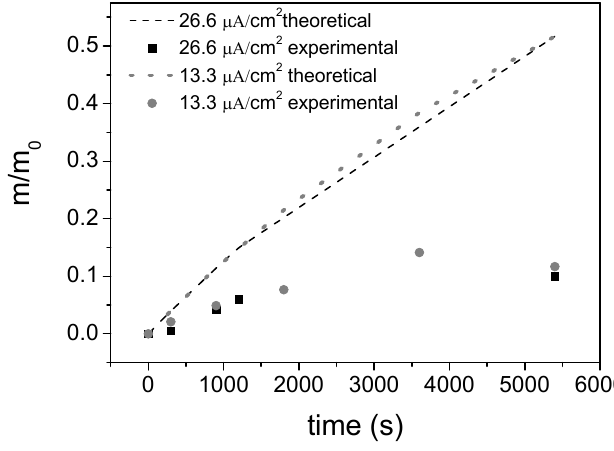
Figure 4. Experimental approximation of the EPD kinetics for NiO-Ni suspensions deposited on a Ni foil substrate. Table 1. EPD parameters.